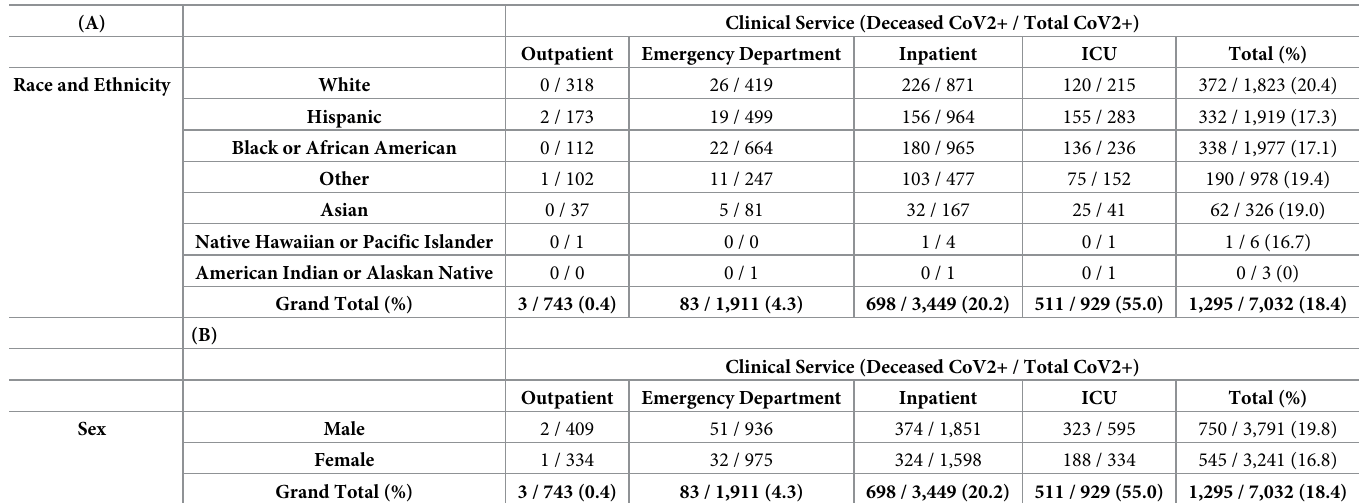
Table 4. COVID-19 mortality in Mount Sinai Health Systems stratified by race and ethnicity and by sex.